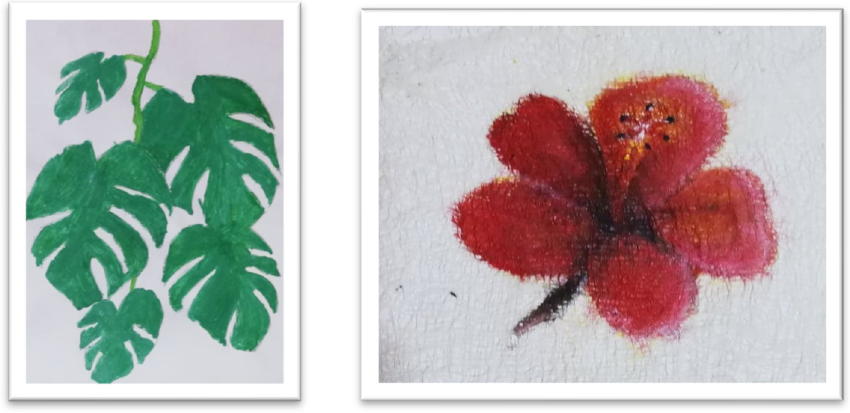
Figure 3. Students’ nature drawing.